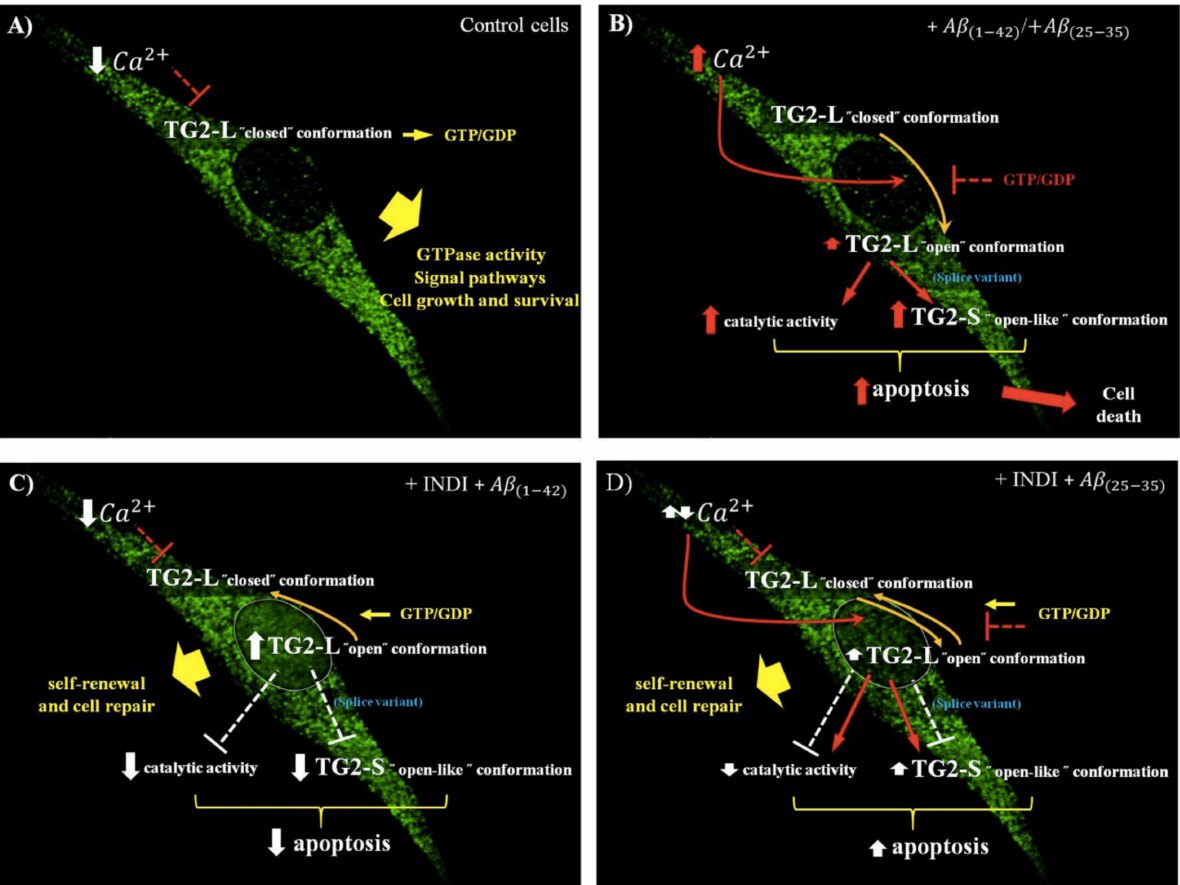
Figure 11. Drawing regarding the effects of OEC treatments with full native peptide A β (1-42) and A β (25-35) fragments on TG2 and its isoform (TG2-L and TG2-S) expression levels both in the absence and presence of indicaxanthin (INDI). ( A ) TG2-L and TG2-S expression levels in OECs maintained in normal conditions; ( B ) TG2-L and TG2-S expression levels in OECs exposed to 10 µ M A β (1-42) or A β (25-35) for 24 h; ( C ) TG2-L and TG2-S expression levels in OECs pre-treated with 100 µ M of INDI and exposed to 10 µ M A β (1-42) for 24 h; ( D ) TG2-L and TG2-S expression levels in OECs pre-treated with 100 µ M of INDI and exposed to 10 µ M A β (25-35) for 24 h. Abbreviations: guanosine triphosphate (GTP); guanosine diphosphate (GDP). Color arrows: damage (red); partial recovery (yellow); no damage